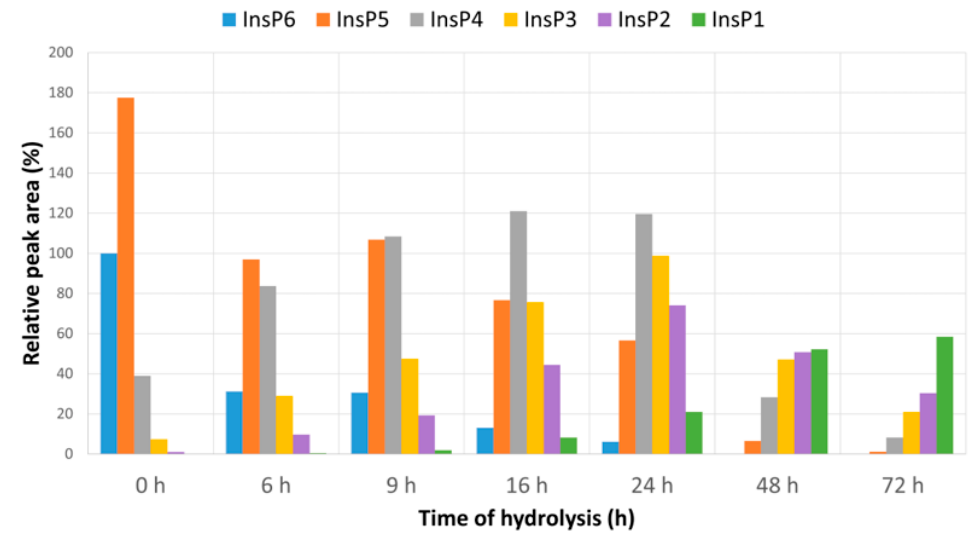
Figure 1. MS signal of the six InsPs after different times of hydrolysis (0 to 72 h) relative to the InsP 6 signal at 0 h. MS/MS was used for measurements, the absolute level of InsP 6 at 0 h was 1.12 µ M and InsP 6 was undetectable at 48 and 72 h.